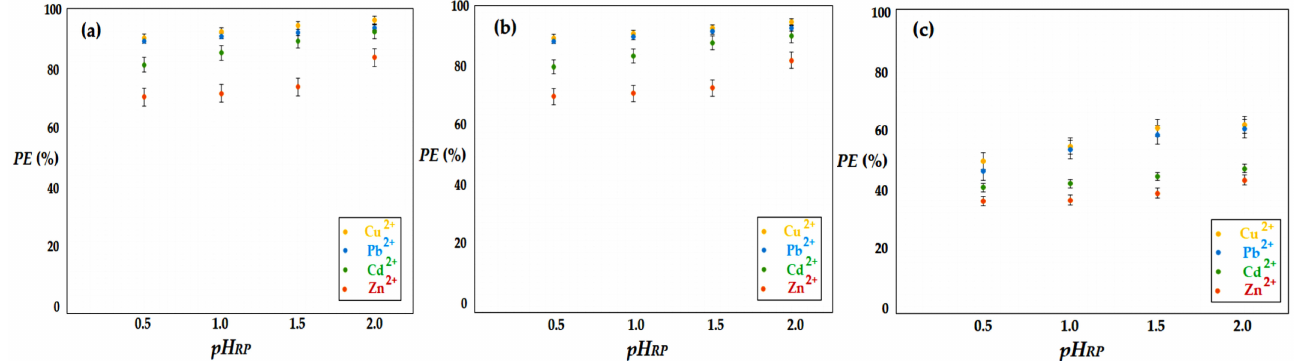
Figure 12. Hydrogen sulfide pertraction efficiency ( PE %) vs. pH for 20 ppm H 2 S in a gas mixture: nitrogen ( a ), methane ( b ), and carbon dioxide ( c